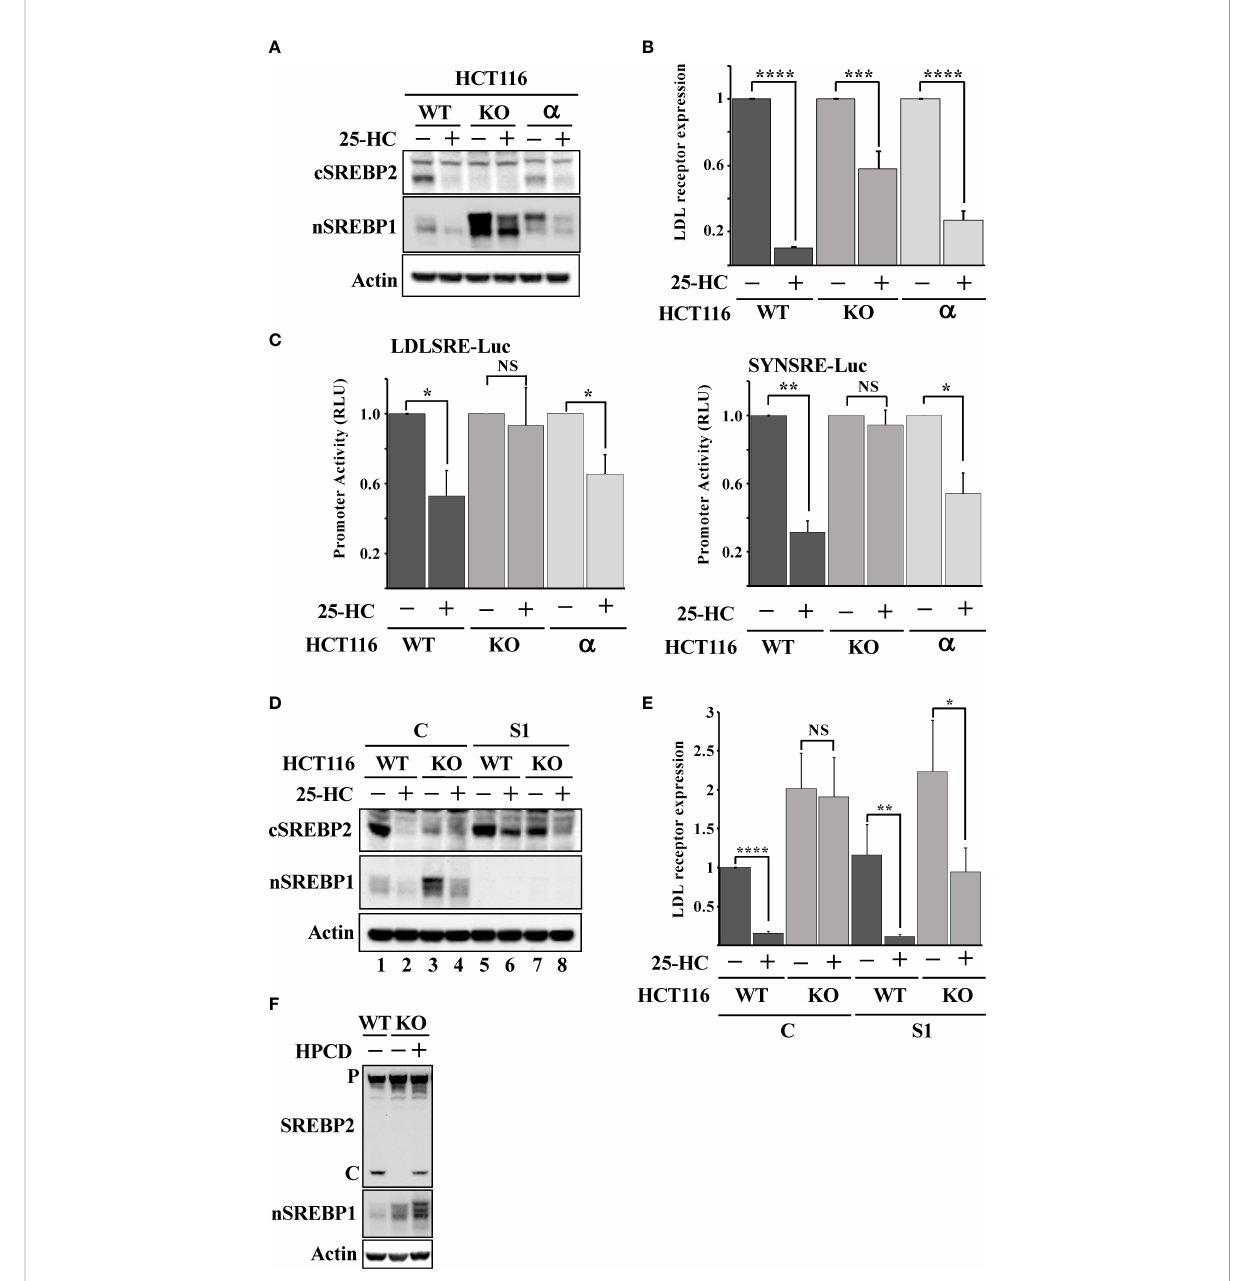
FIGURE 3 Loss of Fbw7 a disrupts cholesterol metabolism. (A) HCT116 cells, either wild-type ( WT ), Fbw7 knockout ( KO ), or the same cells reconstituted with Fbw7 a ( a ) were treated without (-) or with ( + ) 25-HC for 6 hours. The levels of cleaved SREBP2 ( cSREBP2 ), nuclear SREBP1 ( nSREBP1 ), and b -actin in total lysates were determined by Western blotting. (B) HCT116 cells, either wild-type ( WT ), Fbw7 knockout ( KO ), or the same cells reconstituted with Fbw7 a ( a ) were treated as in ( A ). The expression of LDL receptor mRNA was determined by real-time qPCR. (C) HCT116 cells, either wild-type ( WT ), Fbw7 knockout ( KO ), or the same cells reconstituted with Fbw7 a ( a ) were transfected with luciferase promoter-reporter constructs containing the sterol-responsive portions of the human LDL receptor ( LDLSRE-Luc ) and HMG-CoA synthase ( SYNSRE-Luc ) promoters and treated as in ( A ). At the end of the experiment, cells were lysed, and luciferase activity was measured. (D) HCT116 cells, either wild-type ( WT ) or Fbw7 knockout ( KO ), were transduced with either control ( C ) or SREBP1 ( S1 ) shRNA and left untreated ( - ) or treated ( + ) with 25-HC for 6 hours. The levels of cleaved SREBP2 ( cSREBP2 ), nuclear SREBP1 ( nSREBP1 ), and b -actin in total lysates were determined by Western blotting. (E) HCT116 cells, either wild-type ( WT ) or Fbw7 knockout ( KO ), were transduced and treated as in ( D ). The expression of LDL receptor mRNA was determined by real-time qPCR. (F) HCT116 cells, either wild-type ( WT ) or Fbw7 knockout ( KO ), were left untreated ( - ) or treated ( + ) with HPCD for 2 hours. The levels of cleaved SREBP2, nuclear SREBP1 ( nSREBP1 ), and b -actin in total lysates were determined by Western blotting. P and C denotes the precursor and cleaved forms of SREBP2, respectively. P-values lower than 0.05 were considered statistically signi fi cant. *P < 0.05, **P < 0.01, ***P < 0.001, and ****P < 0.0001. NS , not signi fi